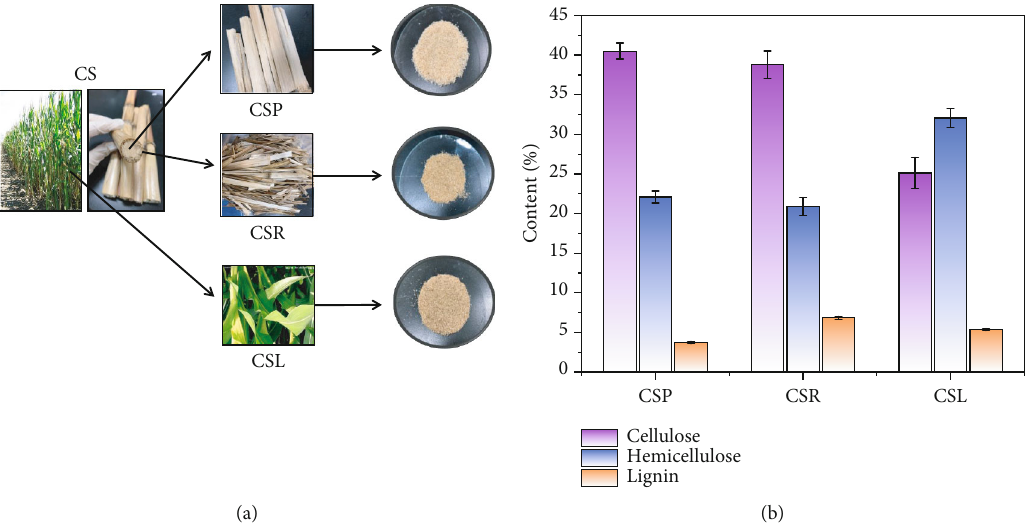
Figure 2: (a) Extraction and preparation of corn stover biomass; (b) content of di ff erent parts of corn stover.